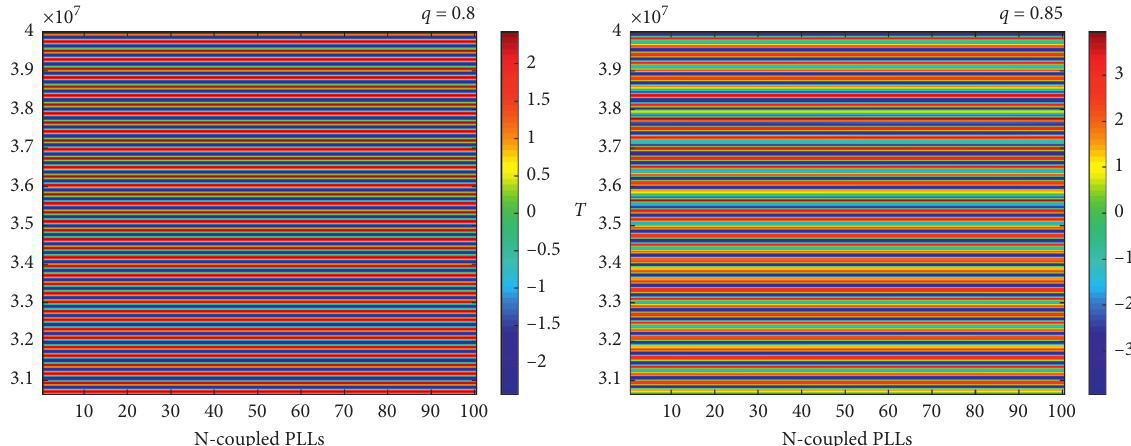
Figure 8: Spatiotemporal behaviour of the FOPLL network for fractional orders q � 0.8 and q � 0.85. We have used random initial conditions with coupling strength D � 1 and parameters K � 2.6 and G �